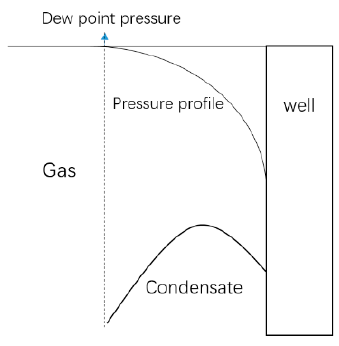
Figure 1. Condensate and pressure profile around the wellbore.